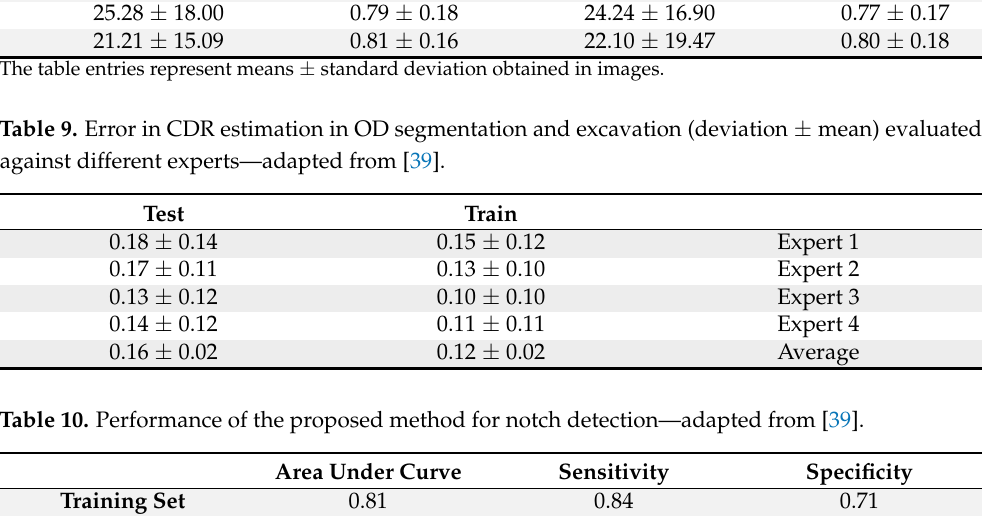
Table 8. Excavation segmentation results—adapted from [39]. Test Train Boundary Localization Error (Pixels)